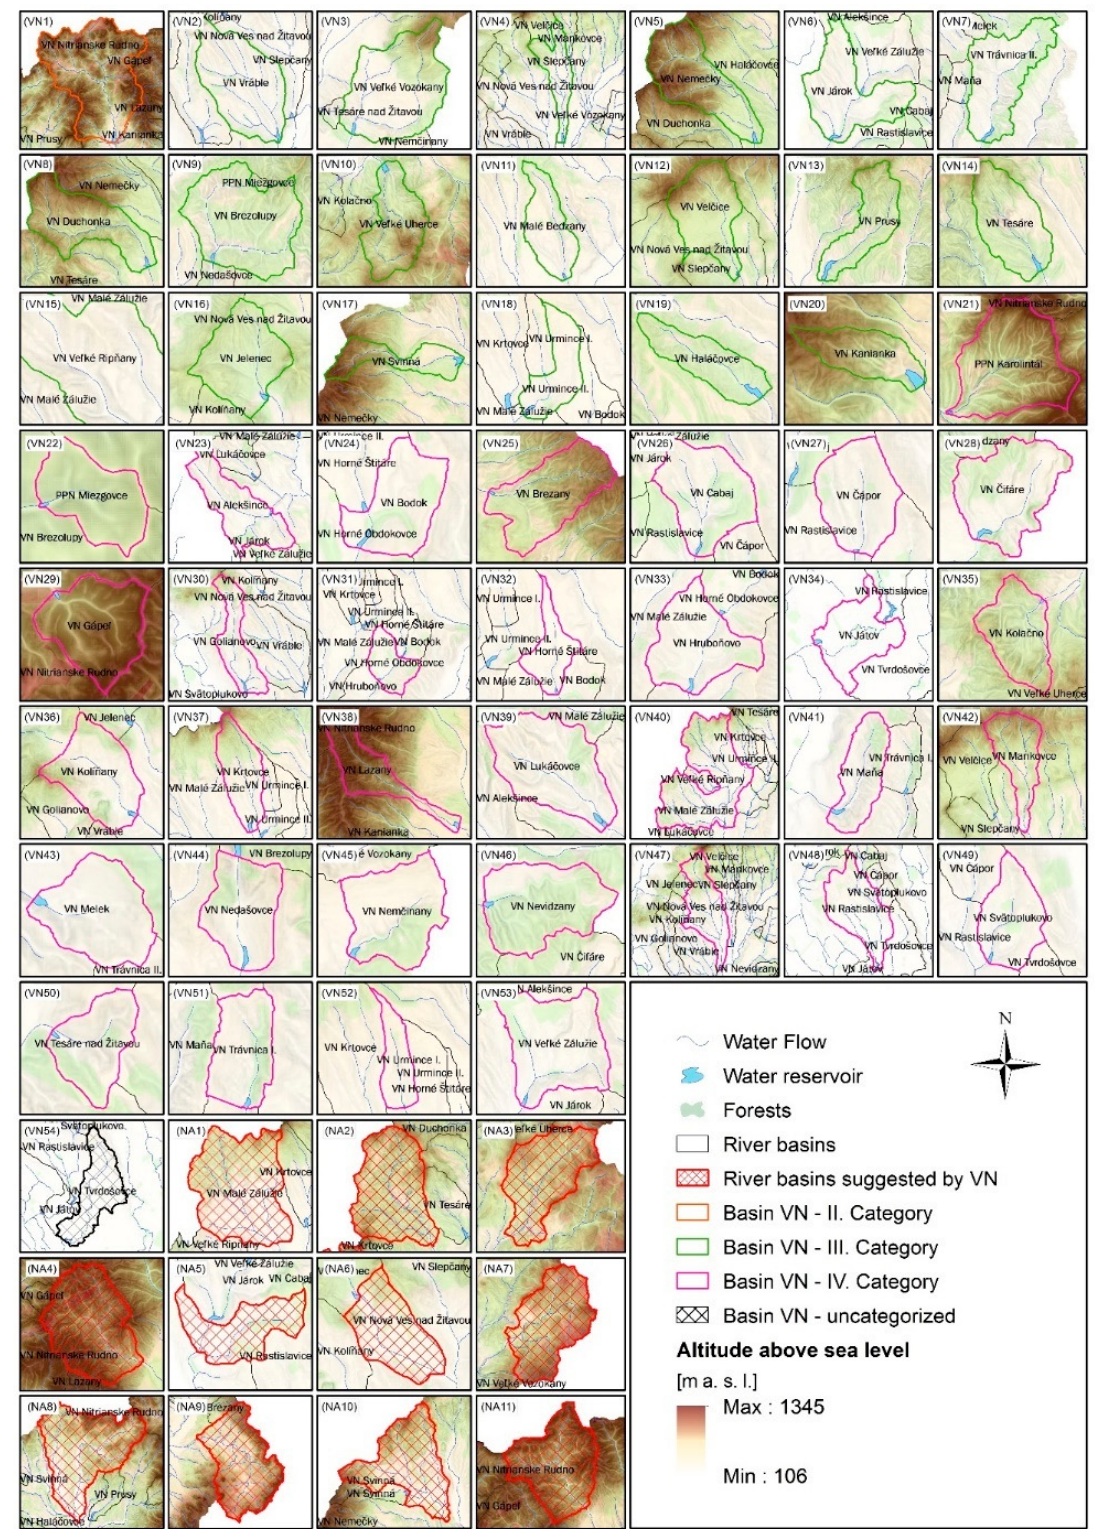
Figure 2. Modeled partial river basins for existing and new reservoirs.